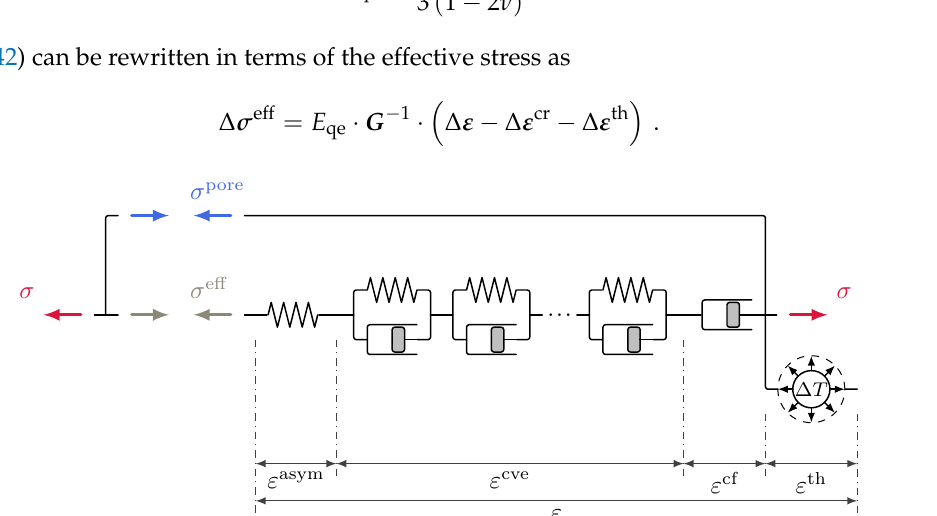
Figure 1. Schematic representation of the multiphase shrinkage and creep formulation driven by a single stress variable, the effective